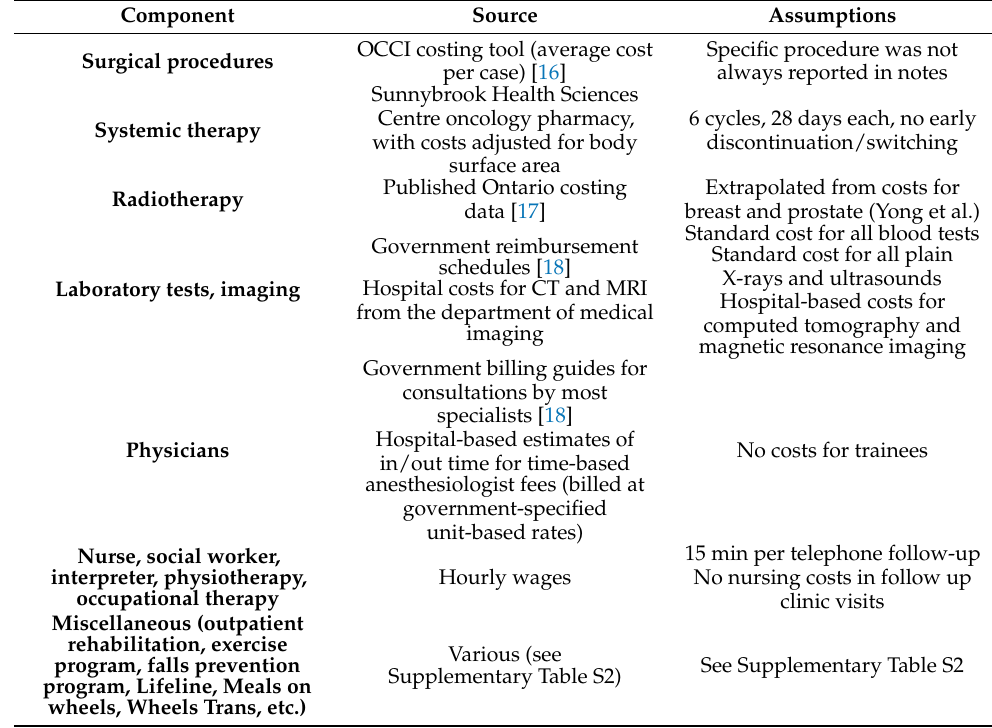
Table 1. Cost components, sources, and related